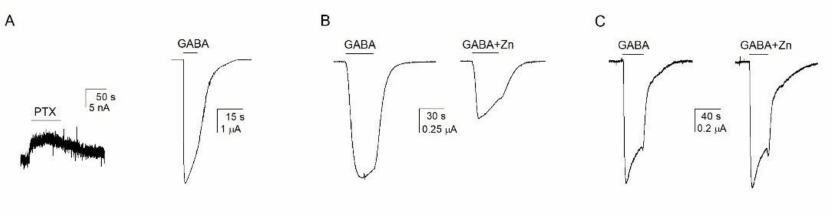
Figure 2. Comparison of properties of α 1 β 2 and α 1 β 2 ε GABA A receptors. ( A ) Sample current responses to 200 µ M picrotoxin (PTX) and 1 mM GABA in a cell expressing α 1 β 2 receptors. Analogous comparison for the α 1 β 2 ε receptor is given in Figure 1A. ( B ) Sample current responses to 3 µ M GABA and 3 µ M GABA + 3 µ M ZnCl 2 in a cell expressing α 1 β 2 receptors. ( C ) Sample current responses to 3 µ M GABA and 3 µ M GABA + 3 µ M ZnCl 2 in a cell expressing α 1 β 2 ε receptors. In all panels, the paired recordings are from the same